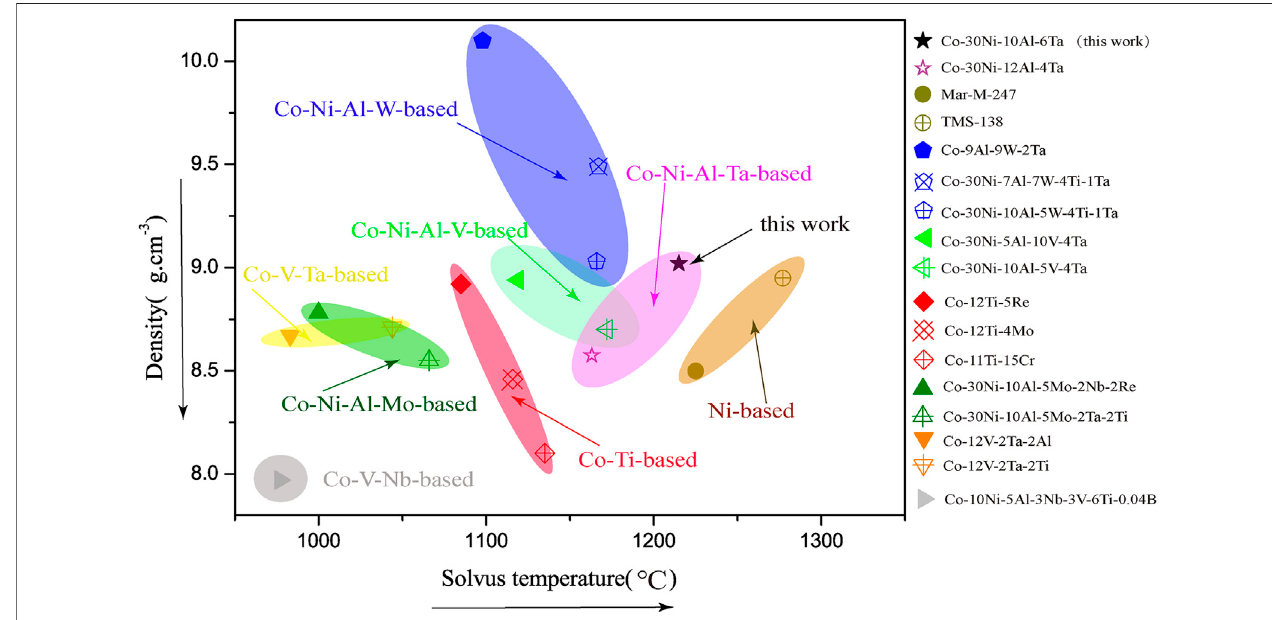
FIGURE 7 | Comparison of lattice mis fi t among Co-Ni-Al-Ta-based, Co-Ni-Al-W-based, Co-Ti-based, Co-Ni-Al-V-based, Co-Ni-Al-Mo-based, and Co-V-Ta- based superalloys.